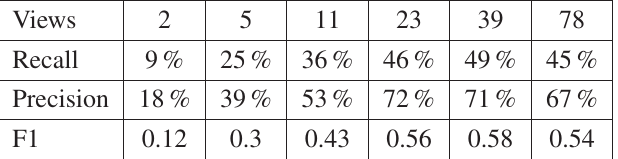
Table 7. Experimental results for various numbers of views in the Parts Database (MatchThresh D 90 %).